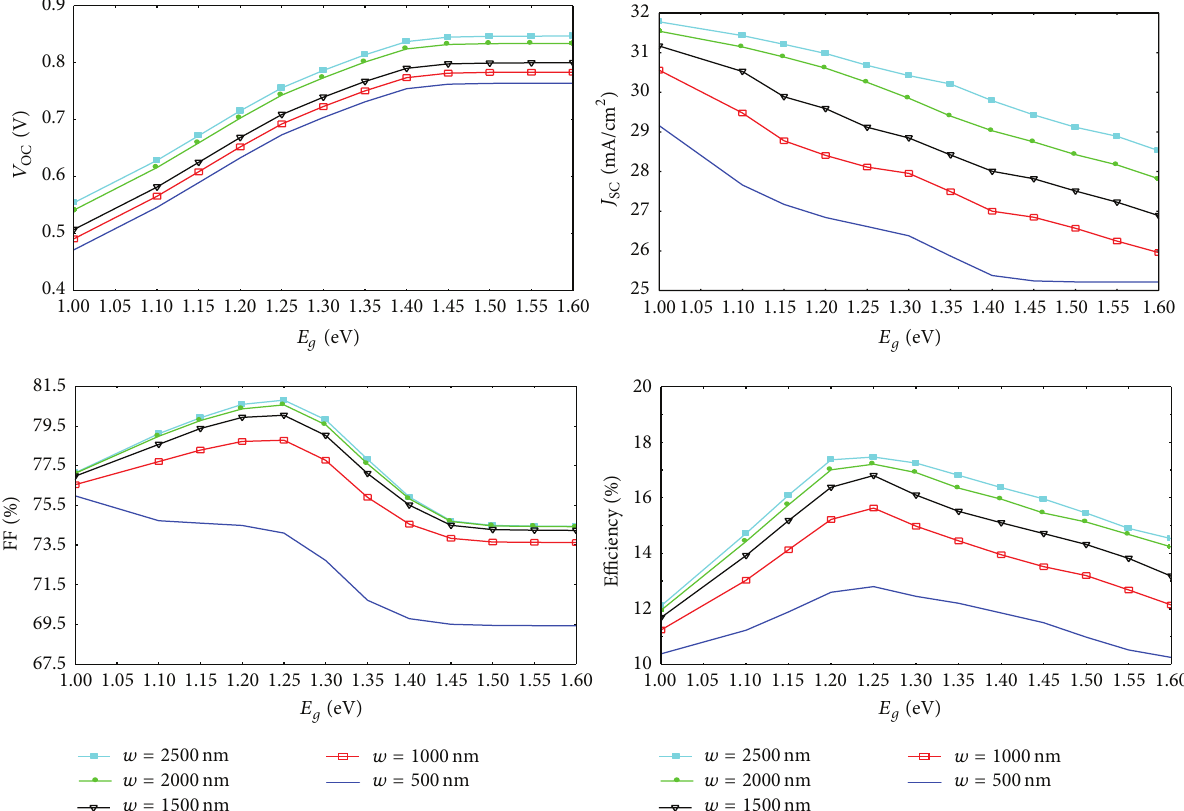
Figure 6: Effect of increasing absorber band gap on the electrical parameters ( 𝑉